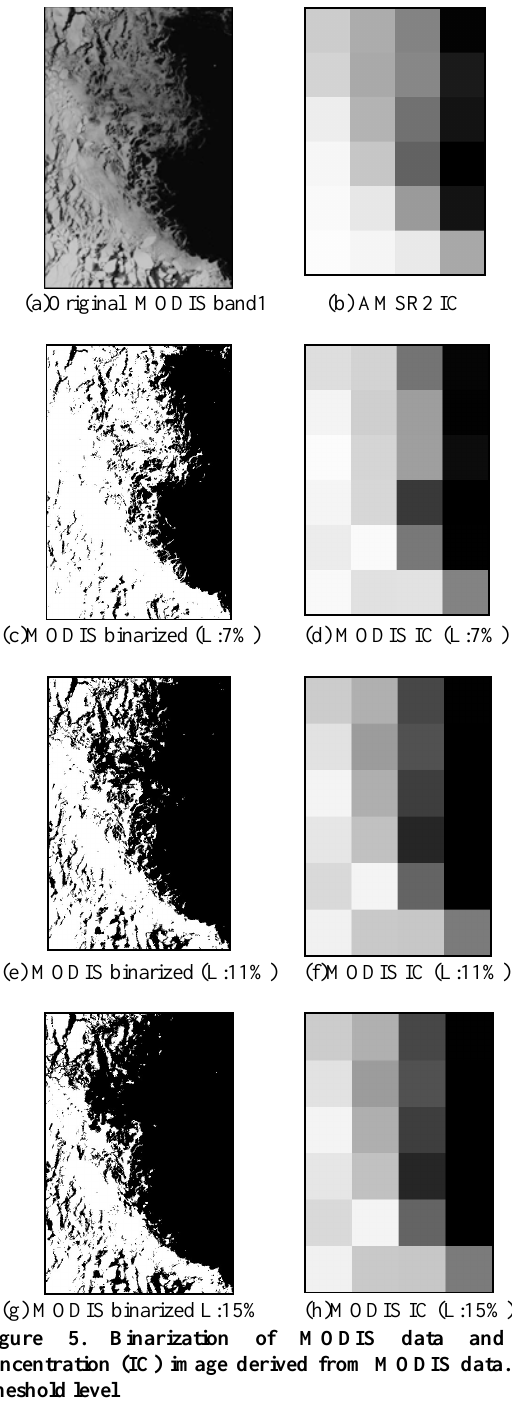
Figure 5 show examples of how the sea ice concentration calculated from MODIS data change as the threshold level of MODIS for binarization change. The reflectance of one pixel of MODIS is the average reflectance of the 250m x 250m area consisted of various types of sea ice and open water. If the threshold level is set to low value, many of the low sea ice concentration area will be assigned to “ice”. In this case, the sea ice concentration of one pixel size of AMSR2 will be rather high. On the other hand, if the threshold level is set to high value, many of the low sea ice concentration area will be assigned to “open water”. In this case, the sea ice concentration of one pixel size of AMSR2 will be rather low.